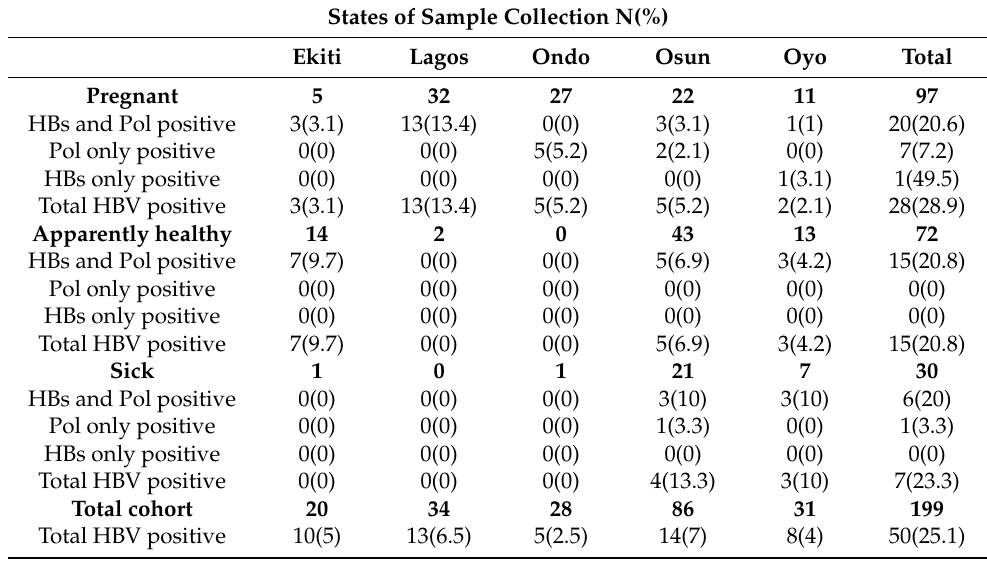
Table 2. Distribution of HBV-PCR-positive samples among the cohort in the States. States of Sample Collection